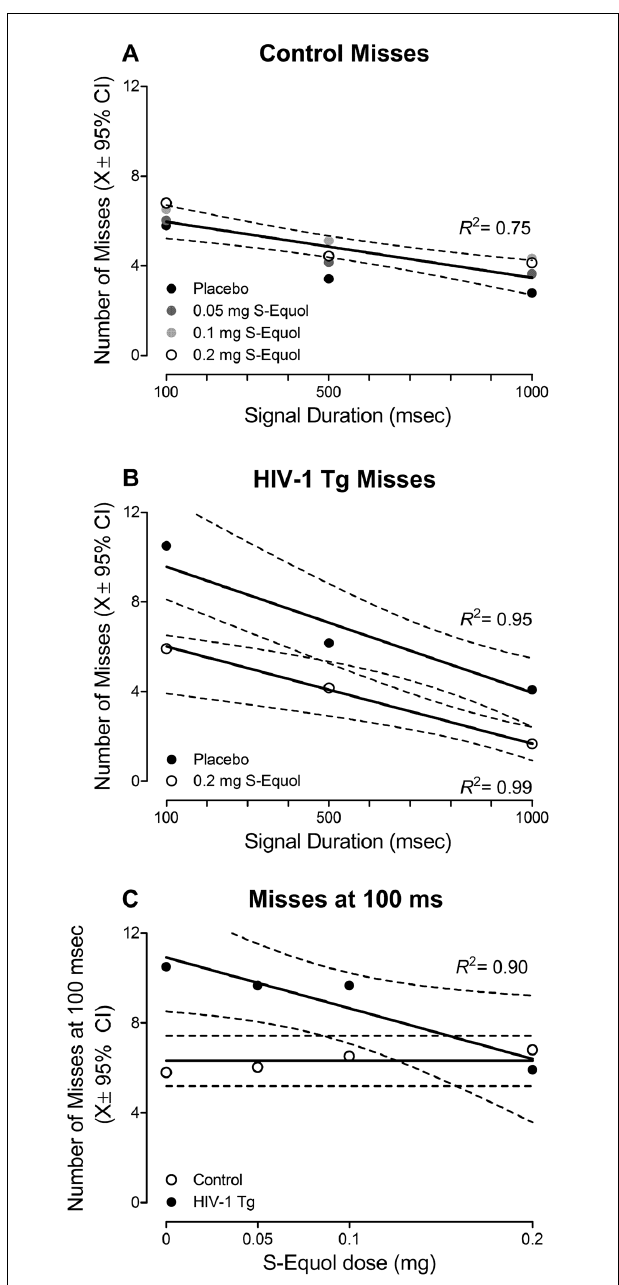
FIGURE 5 | The effect of S-Equol (SE) dose (Placebo, 0.05 mg, 0.1 mg, 0.2 mg) on the number of misses, which reflect a lapse of attention to the stimulus, was examined. (A) Treatment with SE did not significantly alter the number of misses across signal duration (i.e., 1,000, 500, 100 ms) in control animals. (B) For clarity, only the placebo and 0.2 mg SE dose groups are presented. A downward shift in the number of misses was observed as SE dose increased, with the most prominent shift observed in HIV-1 Tg animals treated with 0.2 mg SE. (C) HIV-1 Tg animals displayed a linear decrease in the number of misses at the 100 ms signal duration as the dose of SE increased. A horizontal line, however, provided a well-described fit for the control animals, supporting no change in the number of misses at 100 ms as a function of SE treatment. The number of misses in HIV-1 Tg animals treated with 0.2 mg SE approached the level of